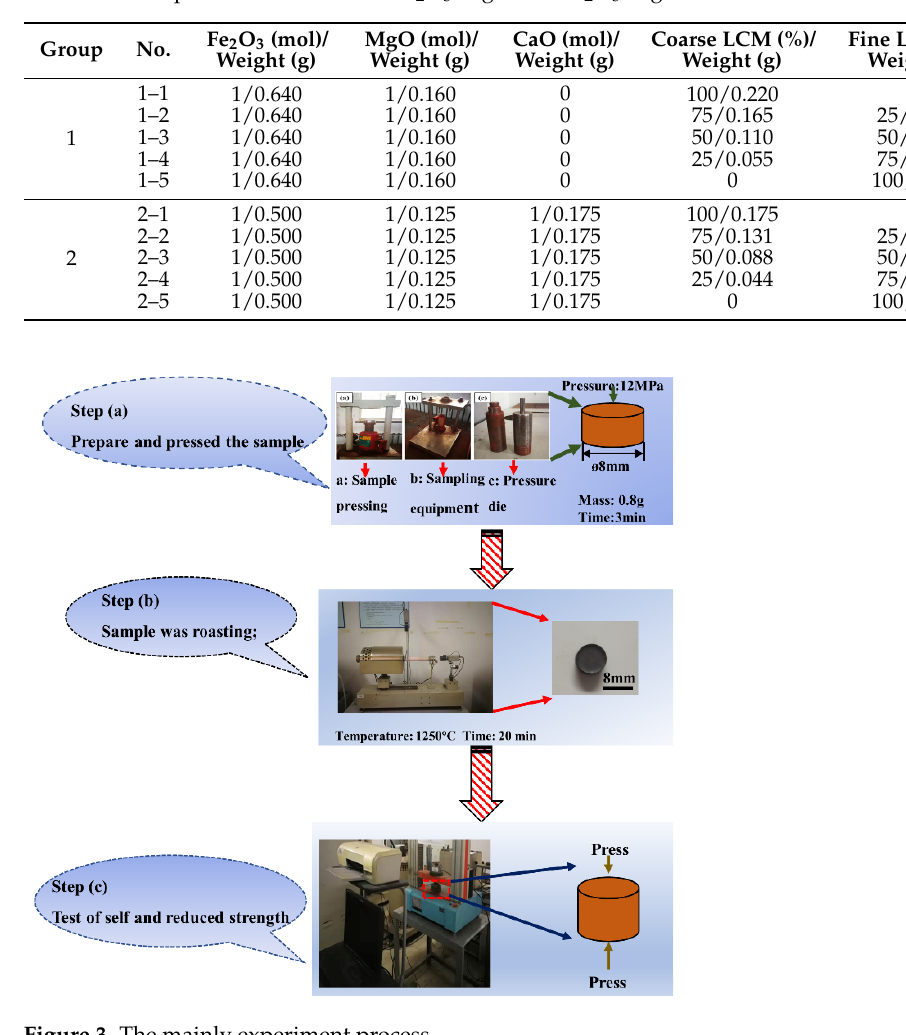
Table 3. The experimental scheme of Fe 2 O 3 -MgO and Fe 2 O 3